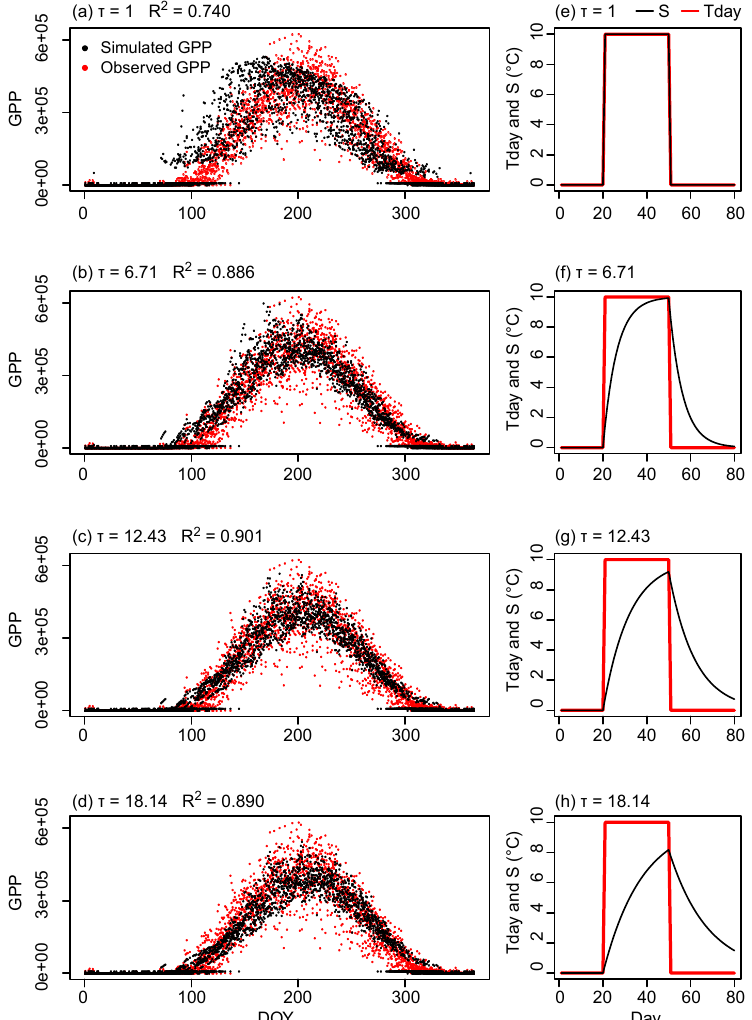
Figure 6. Influence of the temperature transformation ( S) on the modeled annual cycle of GPP daily values (µmolCm − 2 day − 1 ) at the Quebec Eastern Old Black Spruce site. Only the τ parameter determining the S values was allowed to vary, while the other parameters were fixed to the values of plausible block GPP. (a) τ is 1 day ( S same as Tday). (b) τ is 6.71 days (a middle value between 1 and 12.43). (c) τ is 12.43 days (same τ than in plausible block GPP). (d) τ is 18.14 days (a higher value than in plausible block GPP). The R 2 between observations and simulations is reported in each plot. Panels (e–h) show the impact of the respective τ values on S if the daily Tday time series corresponds to a single step of 10 ◦ C lasting 30